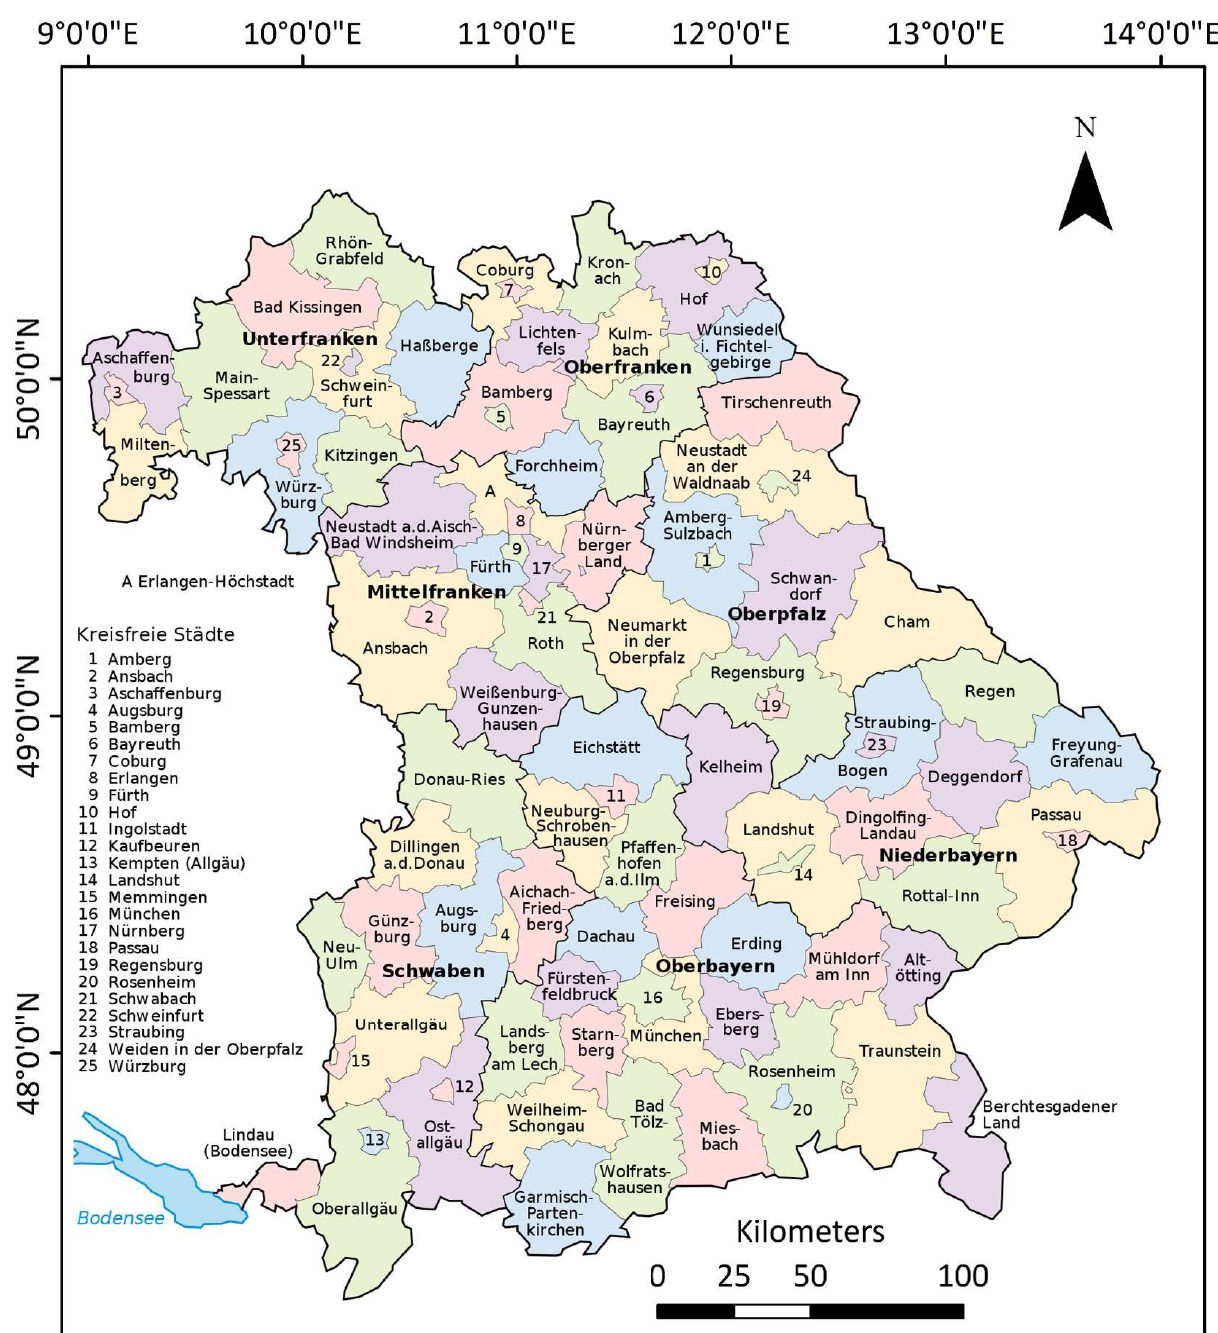
Figure A1. Detailed map of administrative regions of Bavaria (Landkreise und Kreisfreie Städte in Bayern). The names of the districts are translated from German to English: Unterfranken as Lower Franconia, Mittelfranken as Middle Franconia, Oberfranken as Upper Franconia, Oberpfalz as Upper Palatinate, Oberbayern as Upper Bavaria, and Niederbayern as Lower Bavaria. (Source: https://www.gifex.com/, accessed on 12 January 2023).